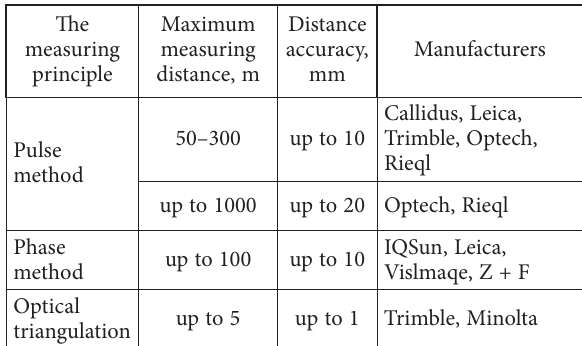
Table 1. Classification of terrestrial laser scanners according